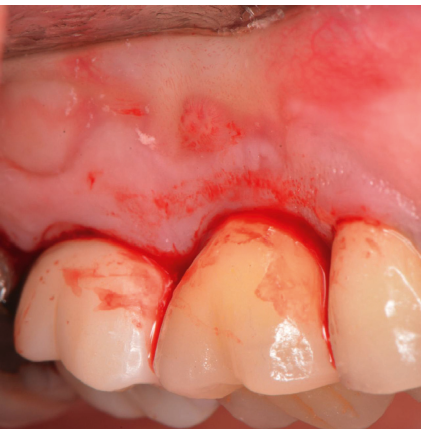
Figure 12: The patient presented at the day of surgical debridement of site #3 with a nondraining fistula at the same site where the fistula was noted before the extraction of #3. The picture is taken after the intrasulcular incisions were performed, with the use of a 15c blade.